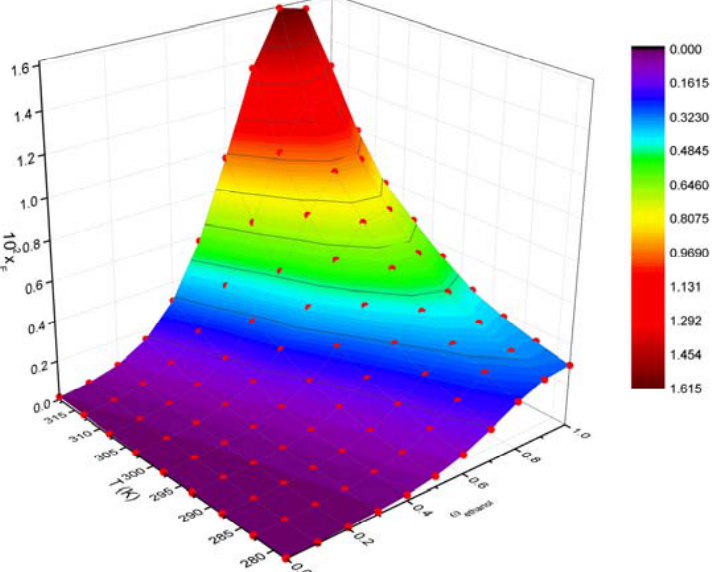
Figure 6. Molar ratio solubility data of florfenicol in 1 ‐ propanol + water binary solvents at T = 278.15 K to 318.15 K.